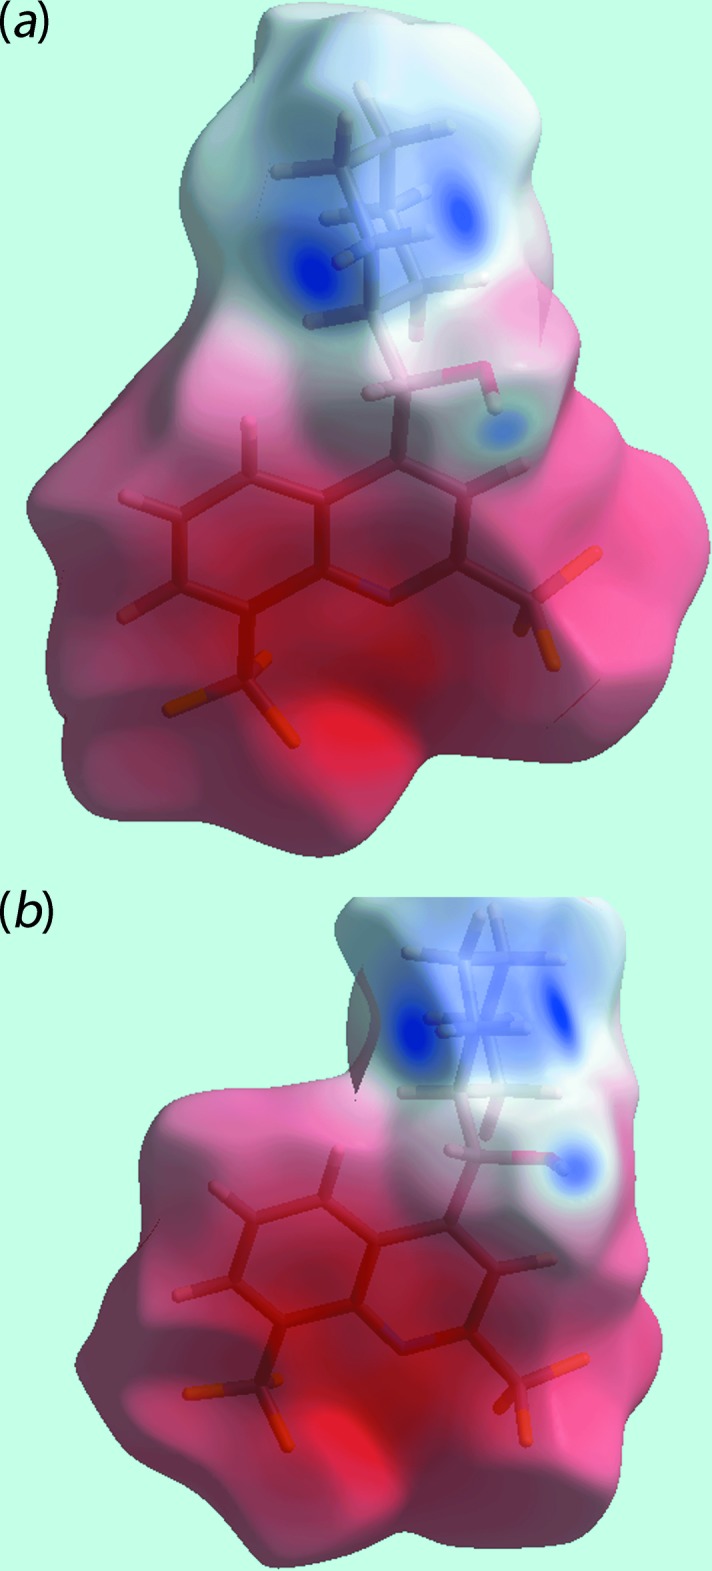
Views of Hirshfeld surface mapped over electrostatic potential for the: (a) O1-containing cation in the range −0.262 to +0.215 atomic units (au) and (b) O2-containing cation (−0.255 to +0.198 au). The red and blue regions represent negative and positive electrostatic potentials, respectively.